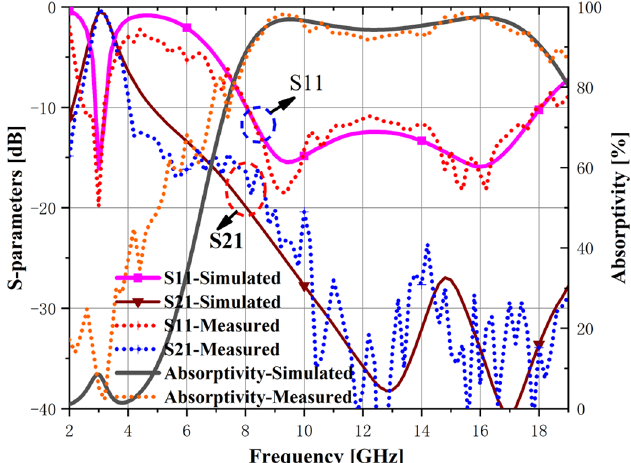
Fig. 9. Measurement and simulation comparison of S-para- meters and absorptivity of FSR prototype under normal